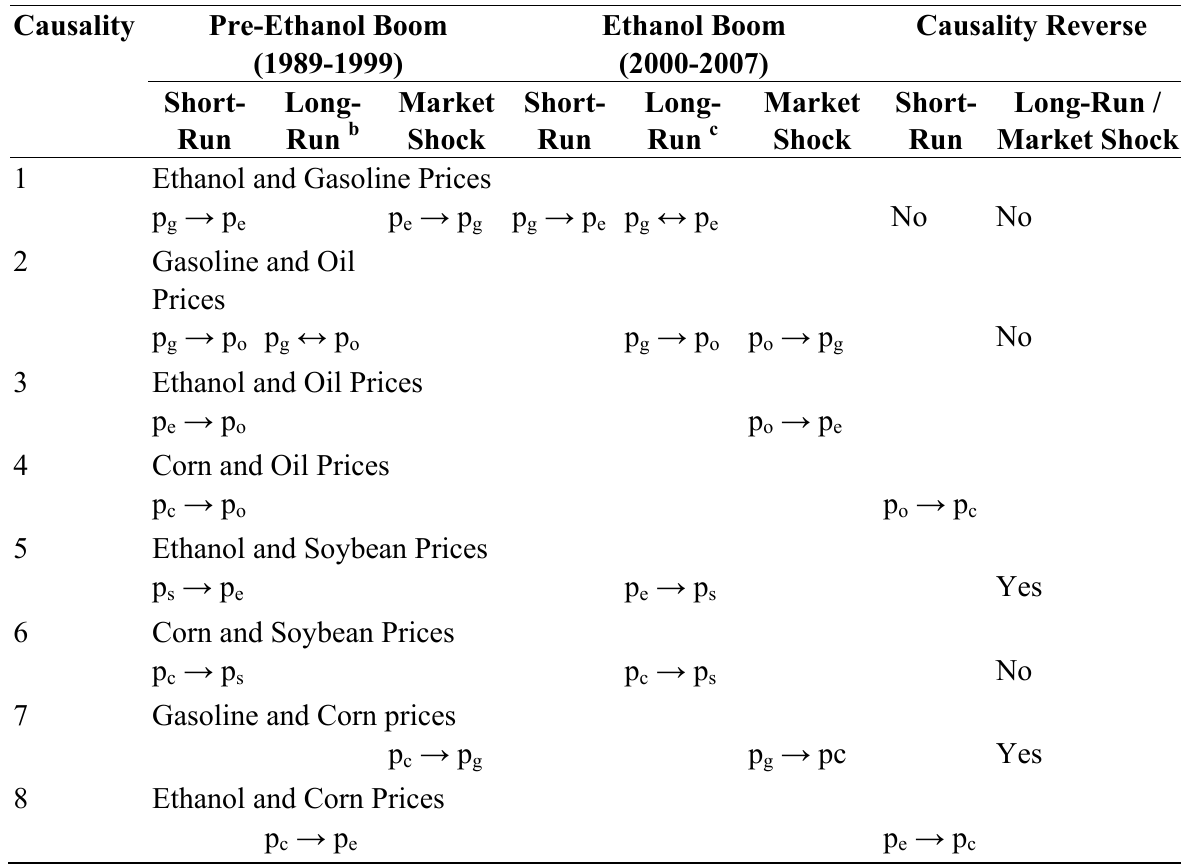
Table 4. Granger Causality Test a